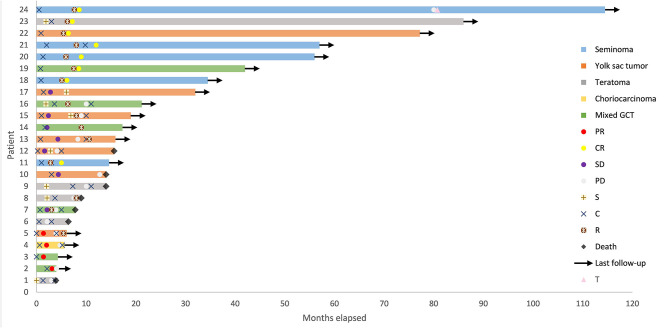
Swimmer Plot depicting time course of primary mediastinal germ cell tumor from diagnosis to death or date of last follow-up. GCT, germ cell tumor; CR, complete remission; PR, partial remission; SD, stable disease; PD, progressive disease; S, surgery; C, chemotherapy; R, radiotherapy; T, autologous hematopoietic progenitor transplantation following high dose chemotherapy.